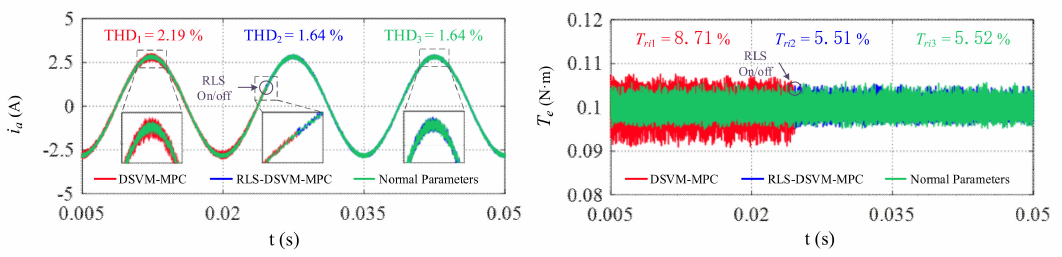
Figure 16. Performance of DSVM-MPC and